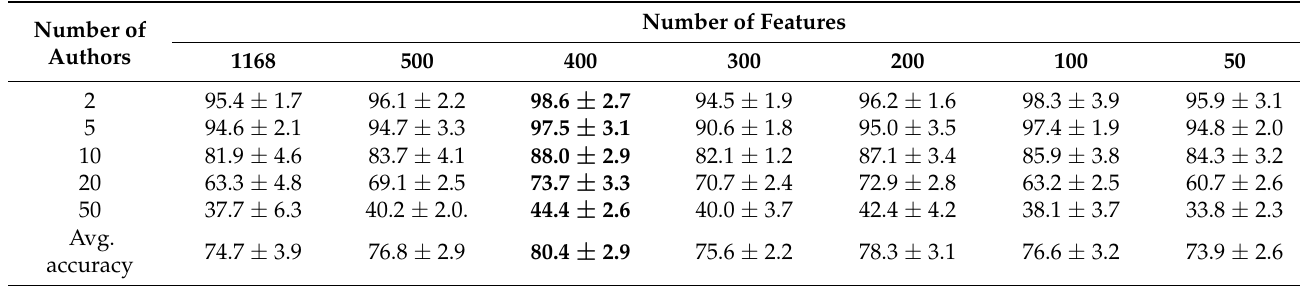
Table 12. Results of GA for literary texts